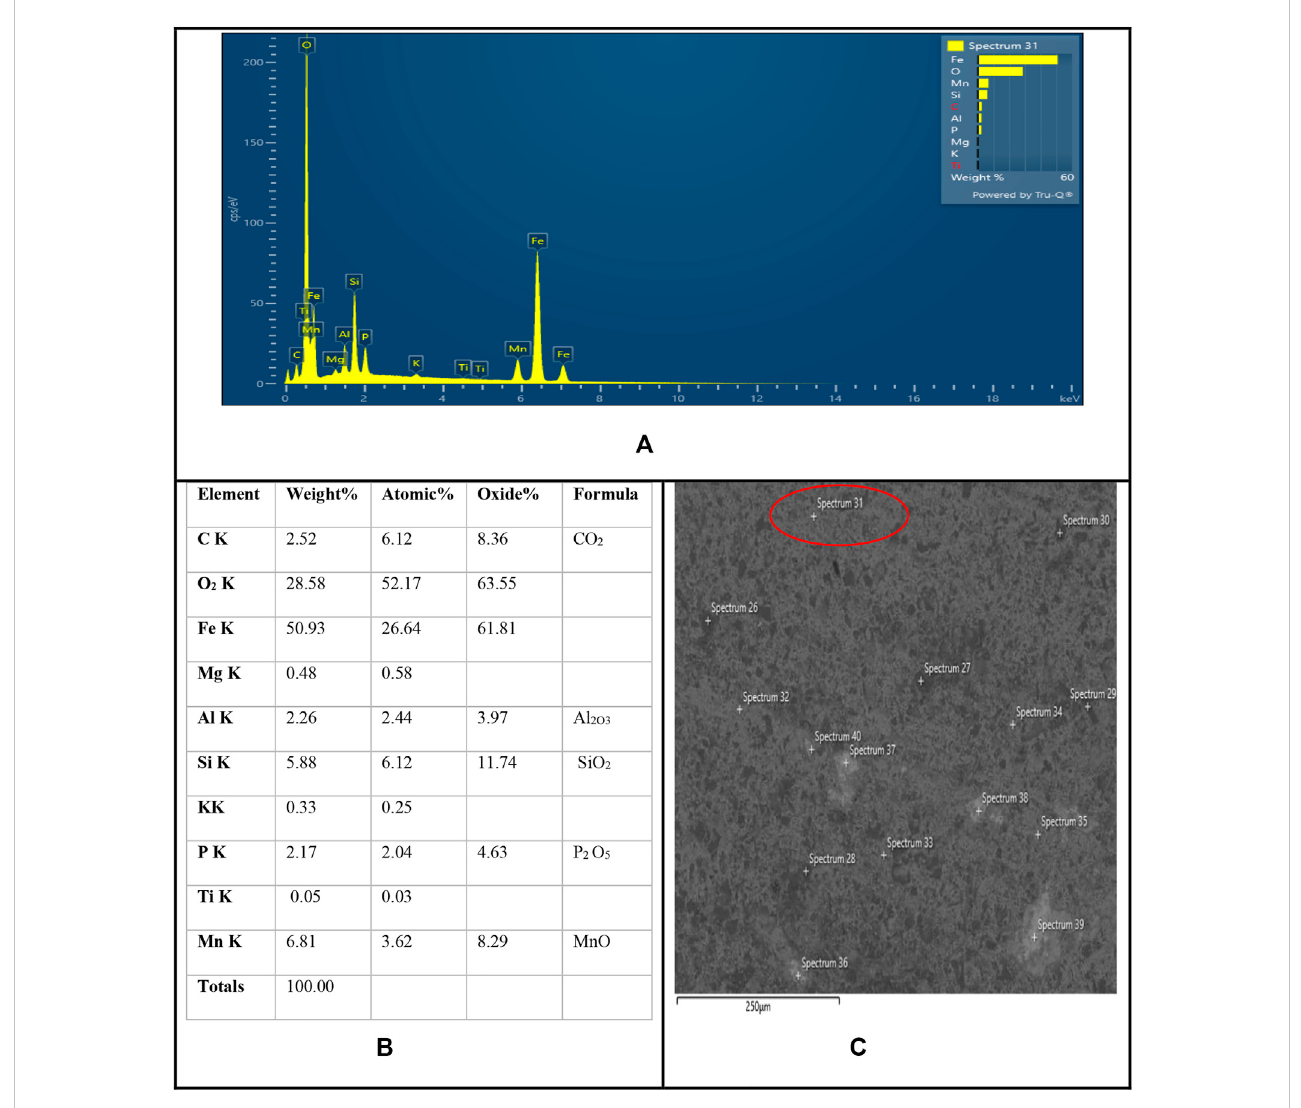
FIGURE 5 Distributionofelementsafterheattreatmentat800 ° CwithEnergyDispersiveSystemAnalysisofX-raysusingSEM. (A) .EnergydispersiveX-ray(EDX)spectra of sample, (B) Table EDS analysis of inclusions from Figure (C) , (C) Complex inclusions in the sample of non-oriented electrical steel sheet containing %